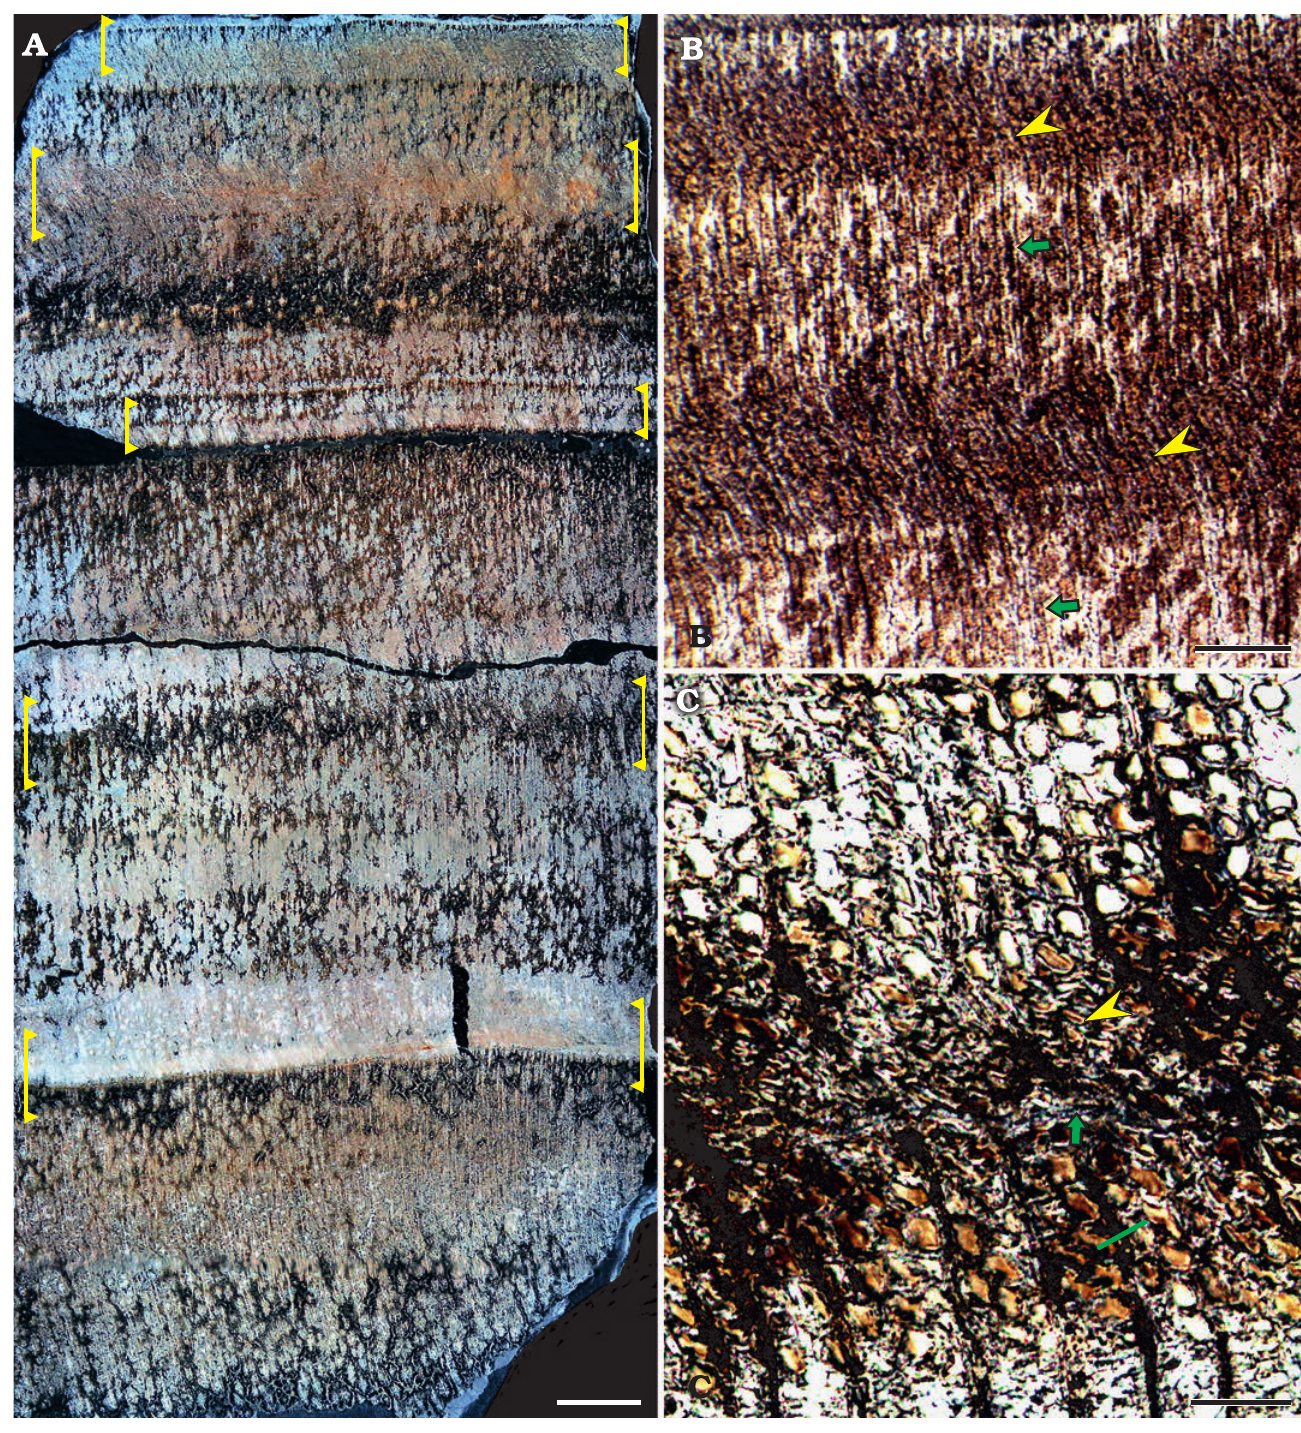
Fig. 7. Araucarian wood Agathoxylon mendezii sp. nov. (MPM­PB­15596), Estancia El Álamo, Santa Cruz Province, Argentina, Berriasian–Valanginian. Transverse sections observed under LM. A . General aspect showing numerous, at least five frost rings (brackets). B , C . Detail of frost rings. B . Two frost rings. Note normal and rectilinear trajectory of rays (arrows) alternate with more sinuous and distended rays (arrowheads). C . Detail of frost ring cell layers, from inside to outside. Note normal tracheids that gradually grade into irregular shaped tracheids (bar) followed by a dark layer of collapsed dead cells (arrow) followed by a layer of distorted axial tracheids difficult to recognise individually. Also note dark contents in lumen cells. Scale bars: A, 3 mm; B, 1.5 mm; C, 150